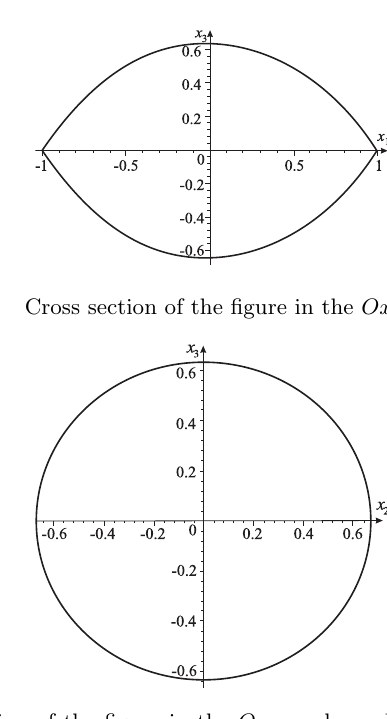
(cid:0) kx 2 (cid:25) 0.6356. This 3 , which is equal to 3